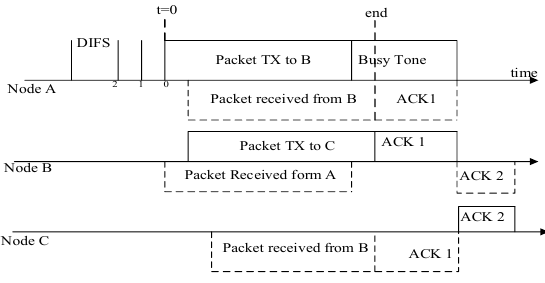
Figure 7. Frame transmission sequence of contraflow [14] in asymmetric